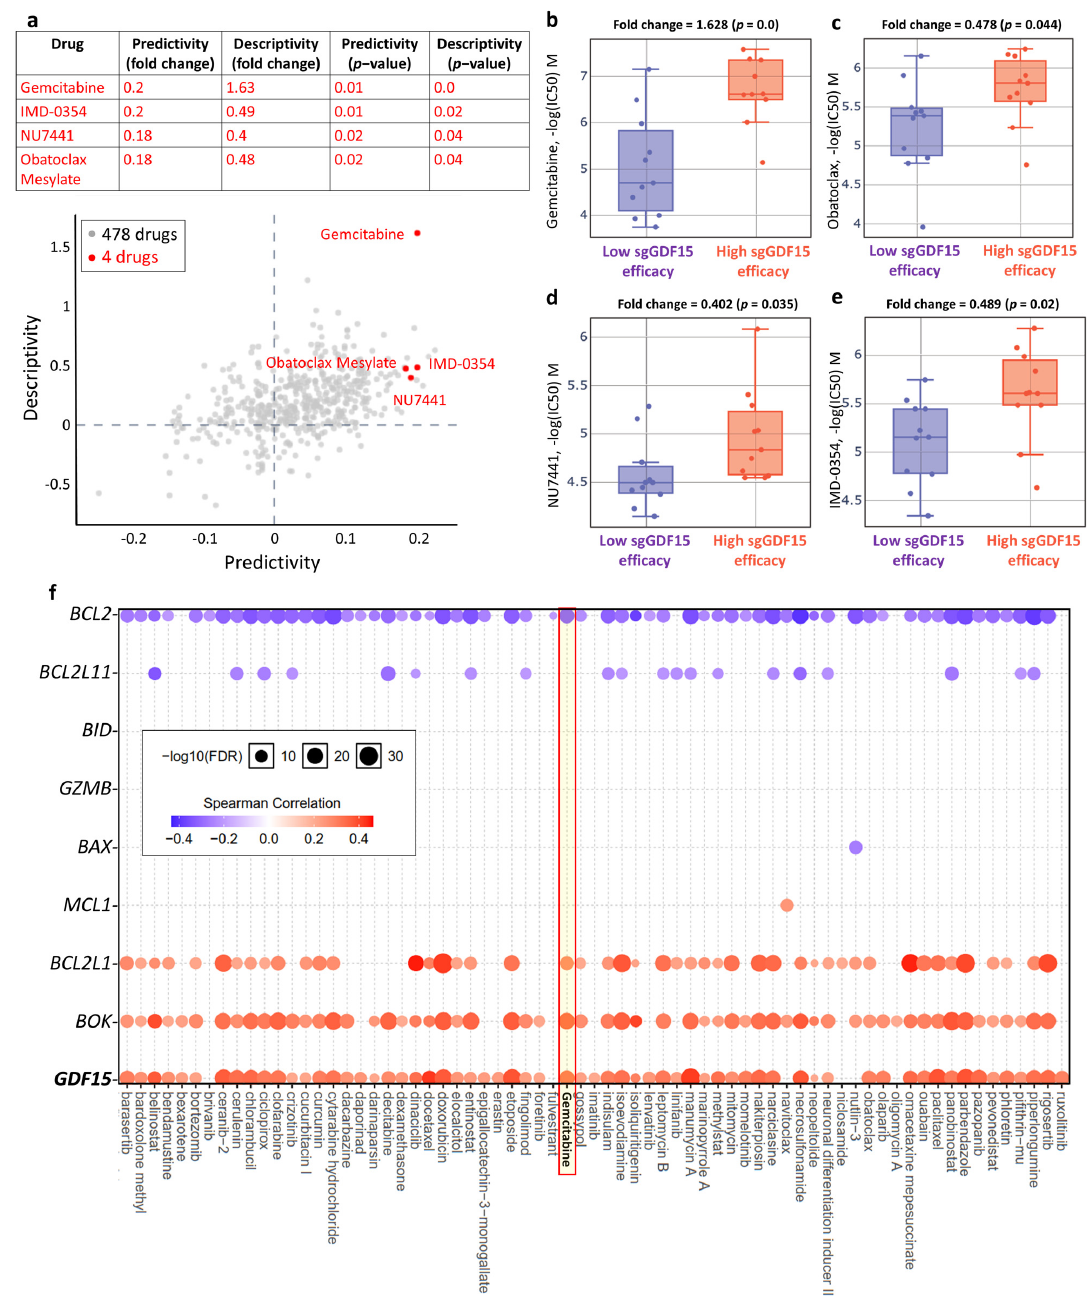
Figure 8. Gemcitabine as a therapeutic option in the context of low GDF15 . Q-omics analysis was used to analyze cross- association scores regarding predictivity and descriptivity for the identification of potent drugs acting on large intestine cells based on GDF15 . ( a ) Predictivity, fold change of single guide GDF15 (sgGDF15) efficacy (sgRNA efficiency of GDF15 knockout) between cells of high and low responses of the target drug. Descriptivity, fold change of target drug response between samples of high and low sgGDF15 efficacy. Red dots represent hits with a predictivity p -value of <0.05 and a descriptivity p -value of <0.05. Boxplots of − log(half maximal inhibitory concentration (IC 50 )) M of Gemcitabine ( b ), obatoclax mesylate ( c ), NU7441 ( d ), and IMD-0354 ( e ) in large intestine cells with low (group 1) and high (group) sgRNA efficacy of GDF15 . ( f ) List of Spearman’s correlation array between drug IC 50 and gene expression, including GDF15 , BOK , BCL2L1 , MCL1 , BAX , GZMB , BID , BCL2L11 , and BCL2 . Note that a positive correlation means that the gene’s low expression indicates drug sensitivity, and vice